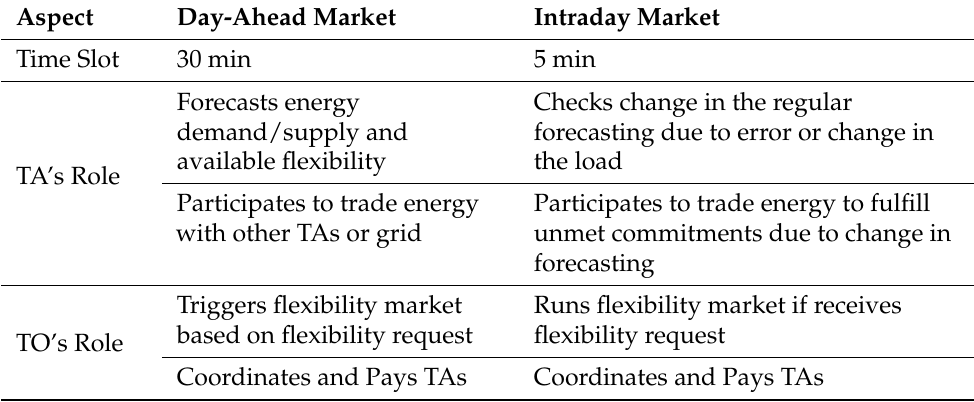
Table 2. Comparison of the Day-ahead and Intraday